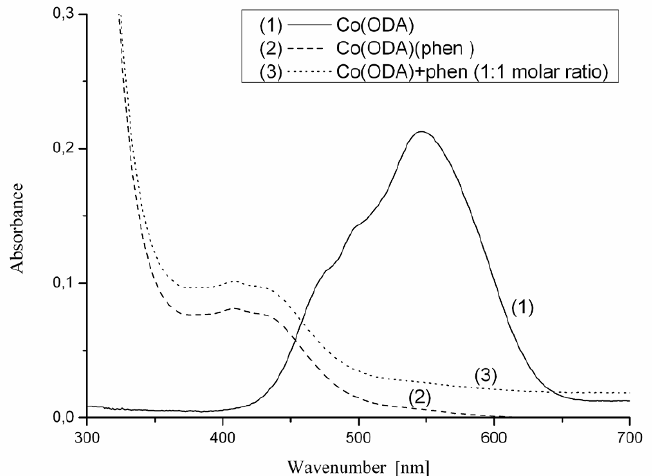
Figure 5. Electronic spectra of the substrate Co-ODA (1), the ternary complex Co-ODA-phen (2) and the product of the substitution reaction Co-ODA + phen (3) in an aqua